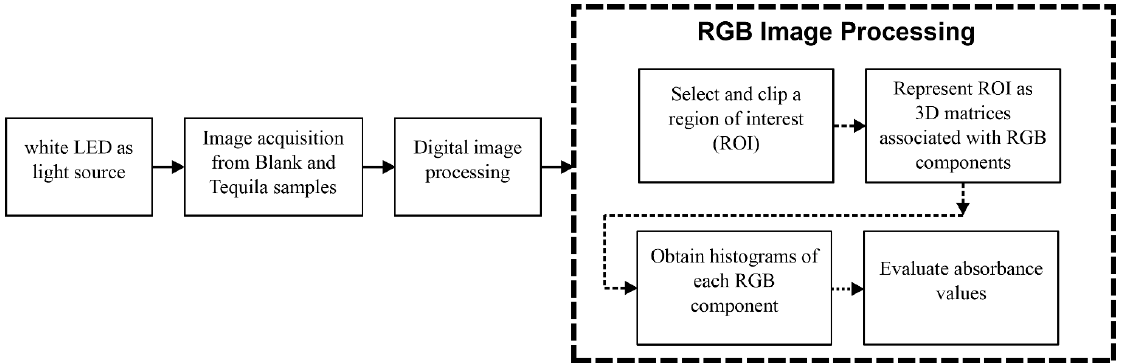
Figure 2. A generalized block diagram of acquisition and identification of image processing performed by the Electronic Eye.